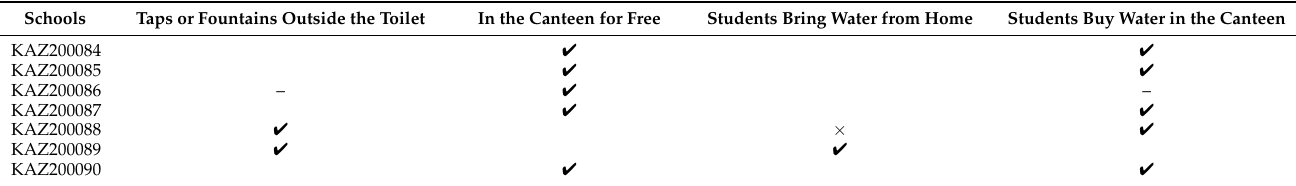
Table 3. Availability of drinking water supply